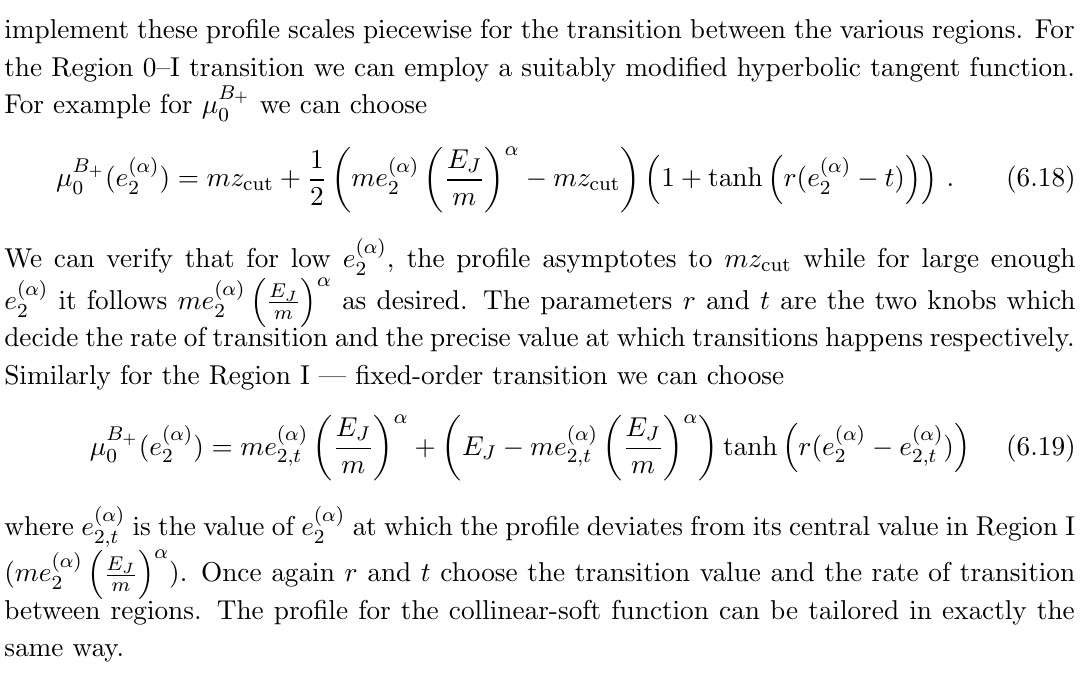
Figure 10 . Resummed cross section at NLL 0 accuracy matched onto one loop (cid:12)xed-order cross